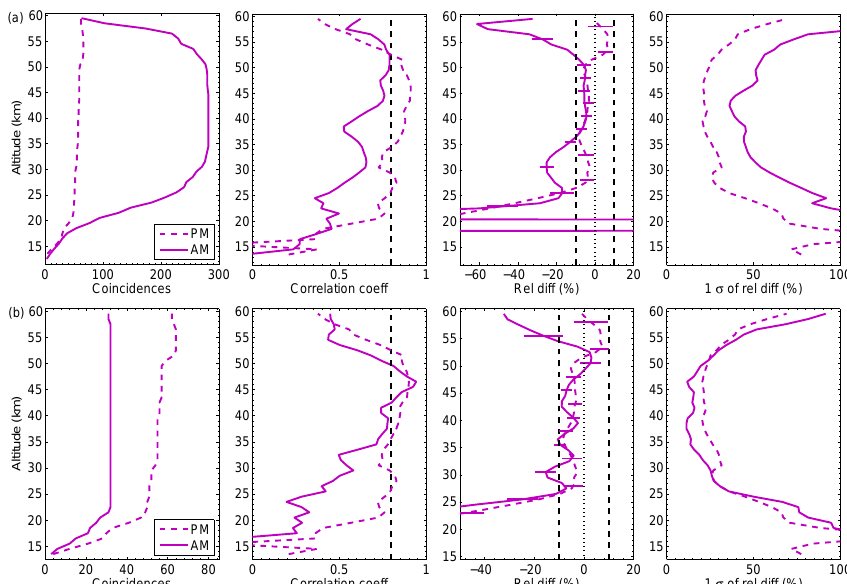
Figure 5. Comparisons of ACE-FTS NO profiles with MIPAS IMK-IAA data within 3h and 100km for local morning (solid lines) and evening (dashed lines) data. From left to right, the plots in each panel show number of coincident profiles, correlation coefficient profiles, mean relative difference profiles (ACE-FTS − MIPAS IMK-IAA) in percent, and standard deviation of relative difference profiles in percent. (a) All data; (b) only summer months (May–Jul in NH, Nov–Jan in SH) are included. Error bars in the relative difference profiles represent the standard error of the